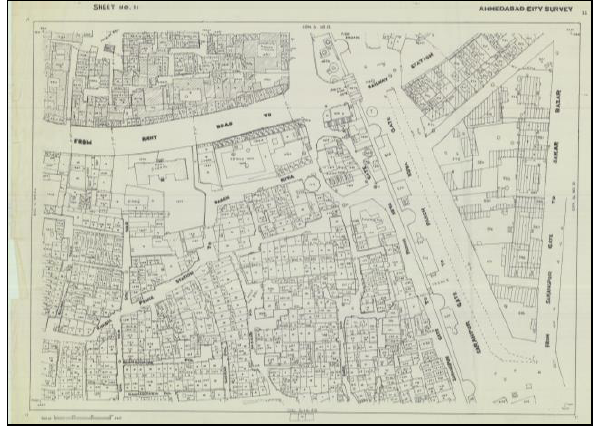
Figure 3. A survey drawing for Ahmedabad